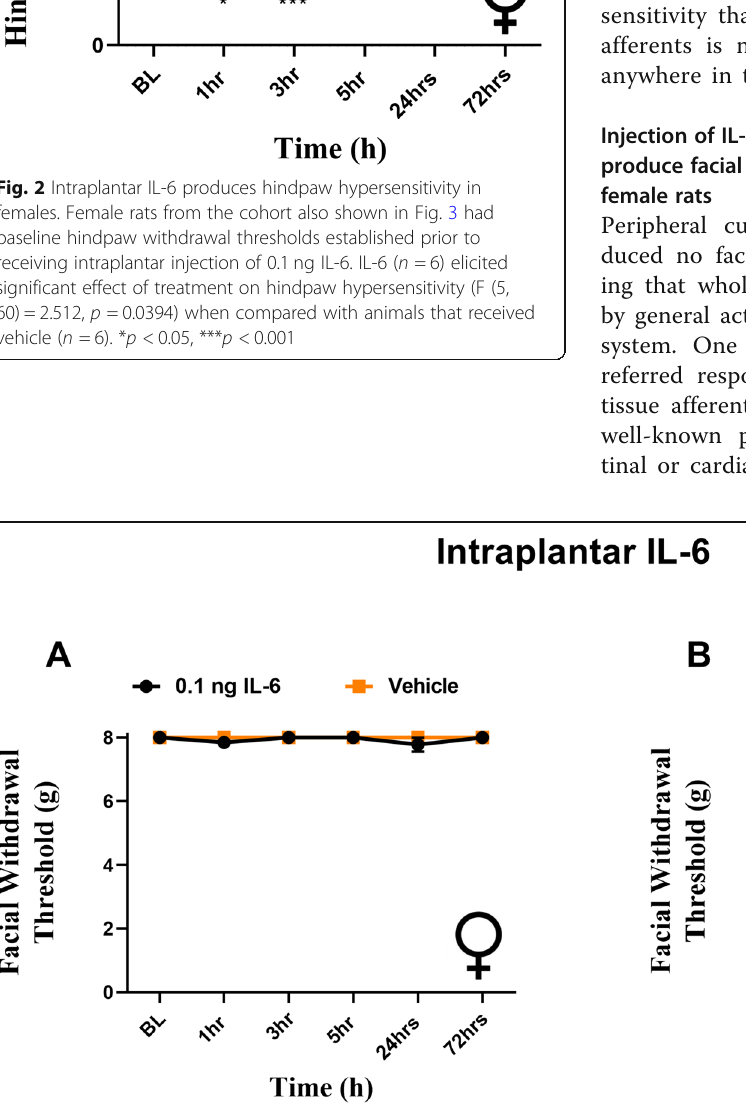
Fig. 3 Intraplantar administration of IL-6 produces no facial responses in female or male rats. Female and male rats had facial hindpaw withdrawal thresholds assessed prior to and following intraplantar injection of 0.1 ng IL-6 (6 females, 6 males) or vehicle (6 females, 6 males). Two-way ANOVA followed by Bonferroni posthoc analysis revealed no significant facial responses in female ( A ) (F (1, 40) = 1.844, p = 0.1821) or male ( B ) (no variation among groups)